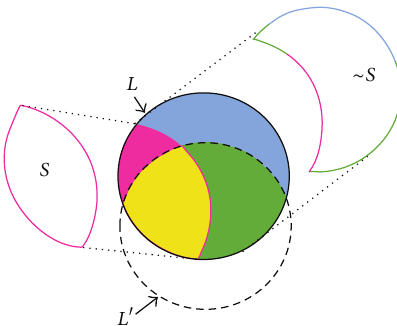
Figure 3: The relationship of itemsets before and after the PPDM process.